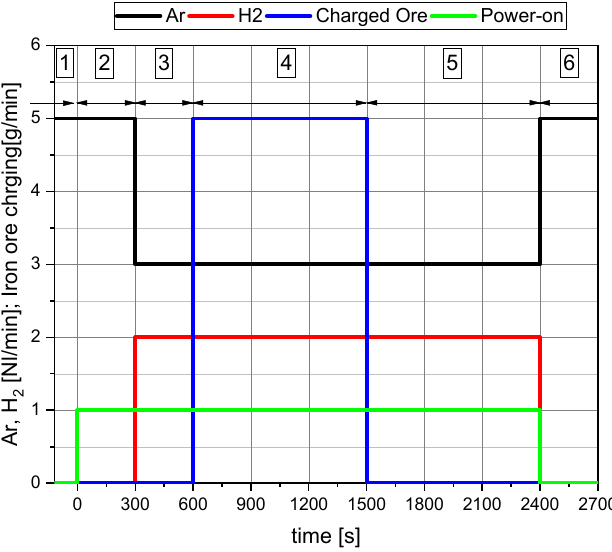
Figure 2. Example of an experimental procedure [14].